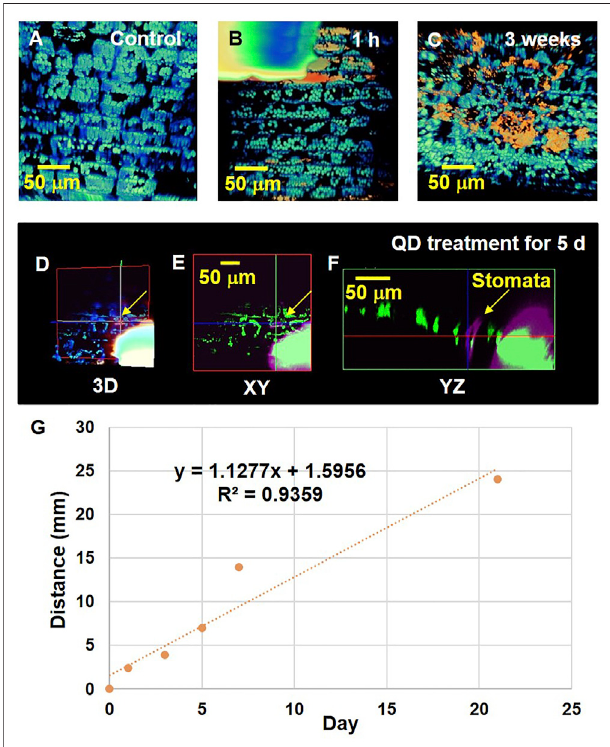
FIGURE 5 | Interaction of QD NPs with garlic chive leaves after drop deposition. QD NP – leaf interactions were investigated after 0, 1, 3, 5, 7, and 21 days of exposure of the leaves to a 2 μ L droplet (1 mg/ml) of QD NPs. (A) 3D reconstruction image showing chlorophyll (blue fl uorescence) distribution in the control garlic chive leaf. A droplet of QD NP suspension was deposited on the abaxial side of the leaf. After being exposed from 1 h (B) to 3 weeks (C) , QD NP absorption (red fl uorescence) into the garlic chive leaf was observed. (D) 3D image showing QD NP uptake into the garlic chive leaf through the stomatal pathway. Cross-sectional images in the xy (E) and yz (F) planes showing the internal morphological structures of garlic chive leaf. Yellow arrowheads indicate stomata. (G) TPM data analysis of QD NP uptake in plant leaves. Y-axis represents the translocation distance of QDs in the leaves over time. The X axis represents the elapsed time after the QD NP droplet